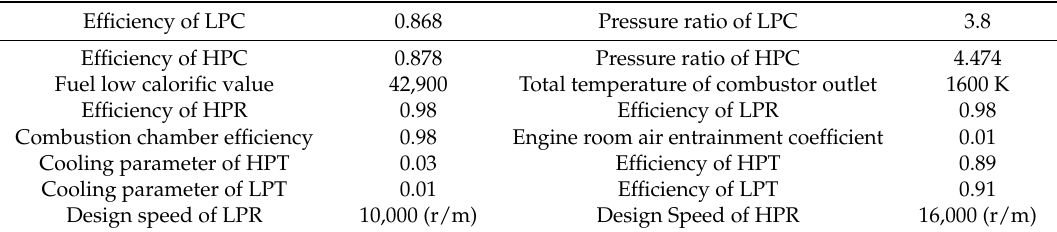
Table 1. Initial working parameters of turbine.